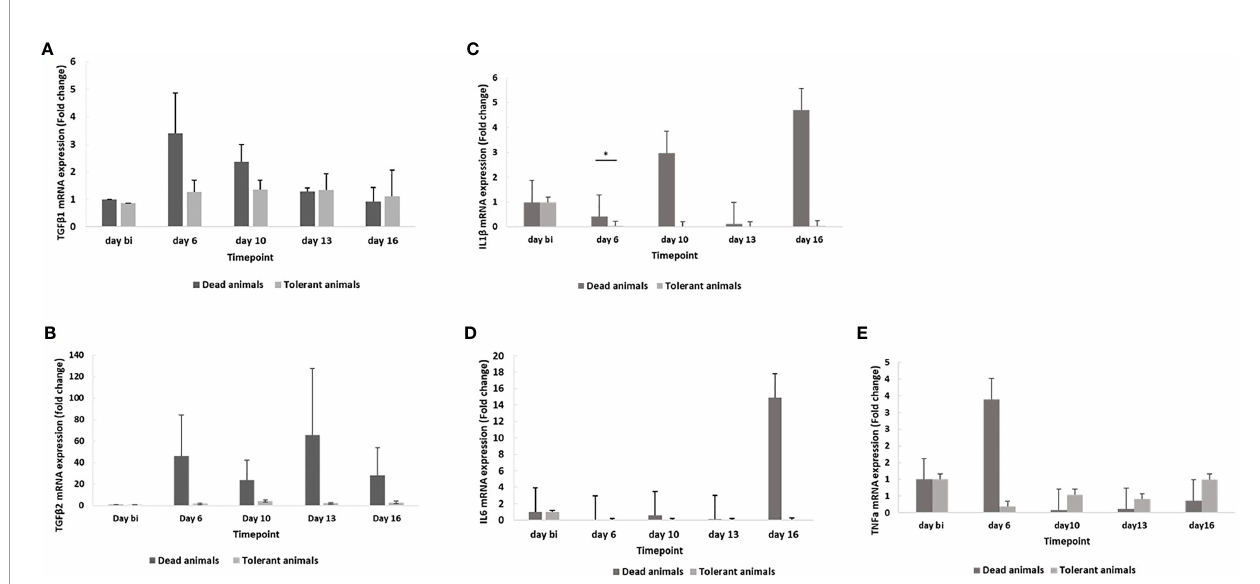
FIGURE 6 | Expression of TGF b 1 (A), TGF b 2 (B), IL1 b (C) , IL6 (D) and TNF a (E) mRNA in susceptible and tolerant cattle. The results were generated from total RNA isolated prior to infection (day bi: day before infection), day 6, day 10, day 13 and day 16 post-infection. The relative amounts of the cytokine transcripts were measured by real time qPCR. The GAPDH gene was used as internal control to normalize mRNA levels. The bars represent STDEV. *p <